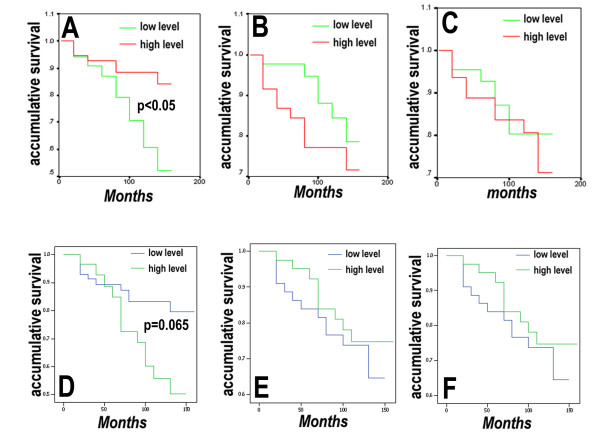
The correlation between Angiomotin (A and D), angiomotin-like-1 (B and E) and angiomotin-like-2 (C and F) and Overall Survival (A-C) and disease free survival (D-F), using Kaplan-Meier survival analysis. Levels of angiomotin transcript were associated with the overall survival (A).